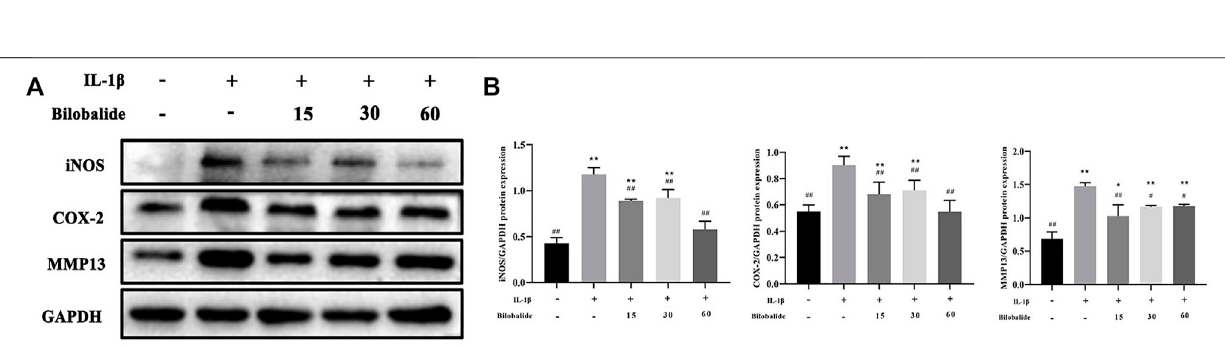
FIGURE1| TheeffectofbilobalideontheviabilityofATDC5chondrocytes. (A) Chemicalstructureofbilobalide. (B,C) Bilobalidecytotoxicityonchondrocytes at12 and 24 h. All data were presented as mean ± SD ( n = 5). * p < .05 indicates signi fi cant differences between different groups compared to the control group (Statistical analysis using one-way ANOVA and paired two-tailed Student ’ s t-test).